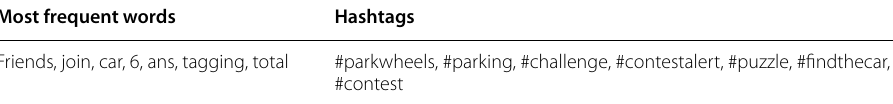
Table 6 Hashtags, and most frequent words within the 21 core community Most frequent